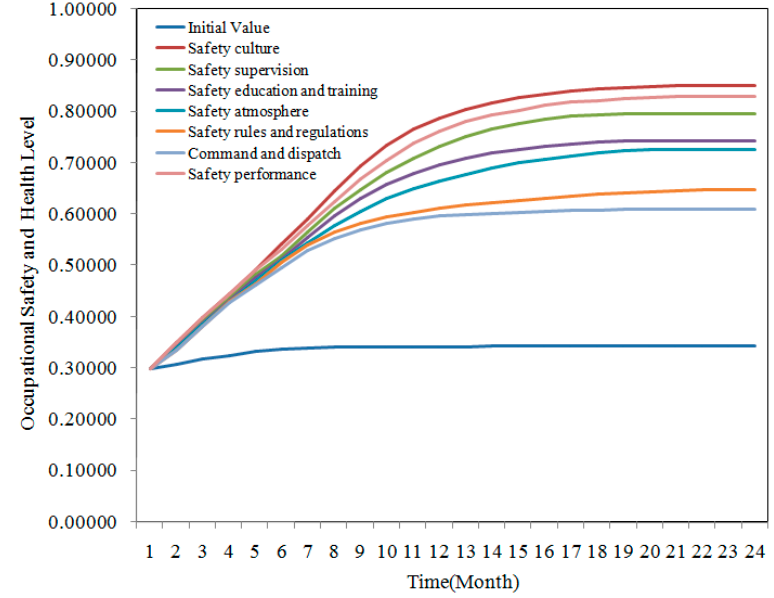
Figure 6. SD simulation of management factor measures.